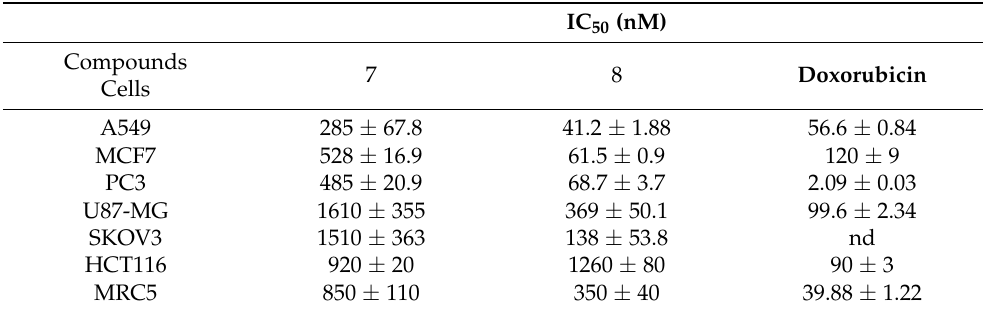
Table 2. Antiproliferative activity of compounds 7 , 8, and doxorubicin upon various cancer human cells and normal cells expressed in terms of IC 50 (nM).